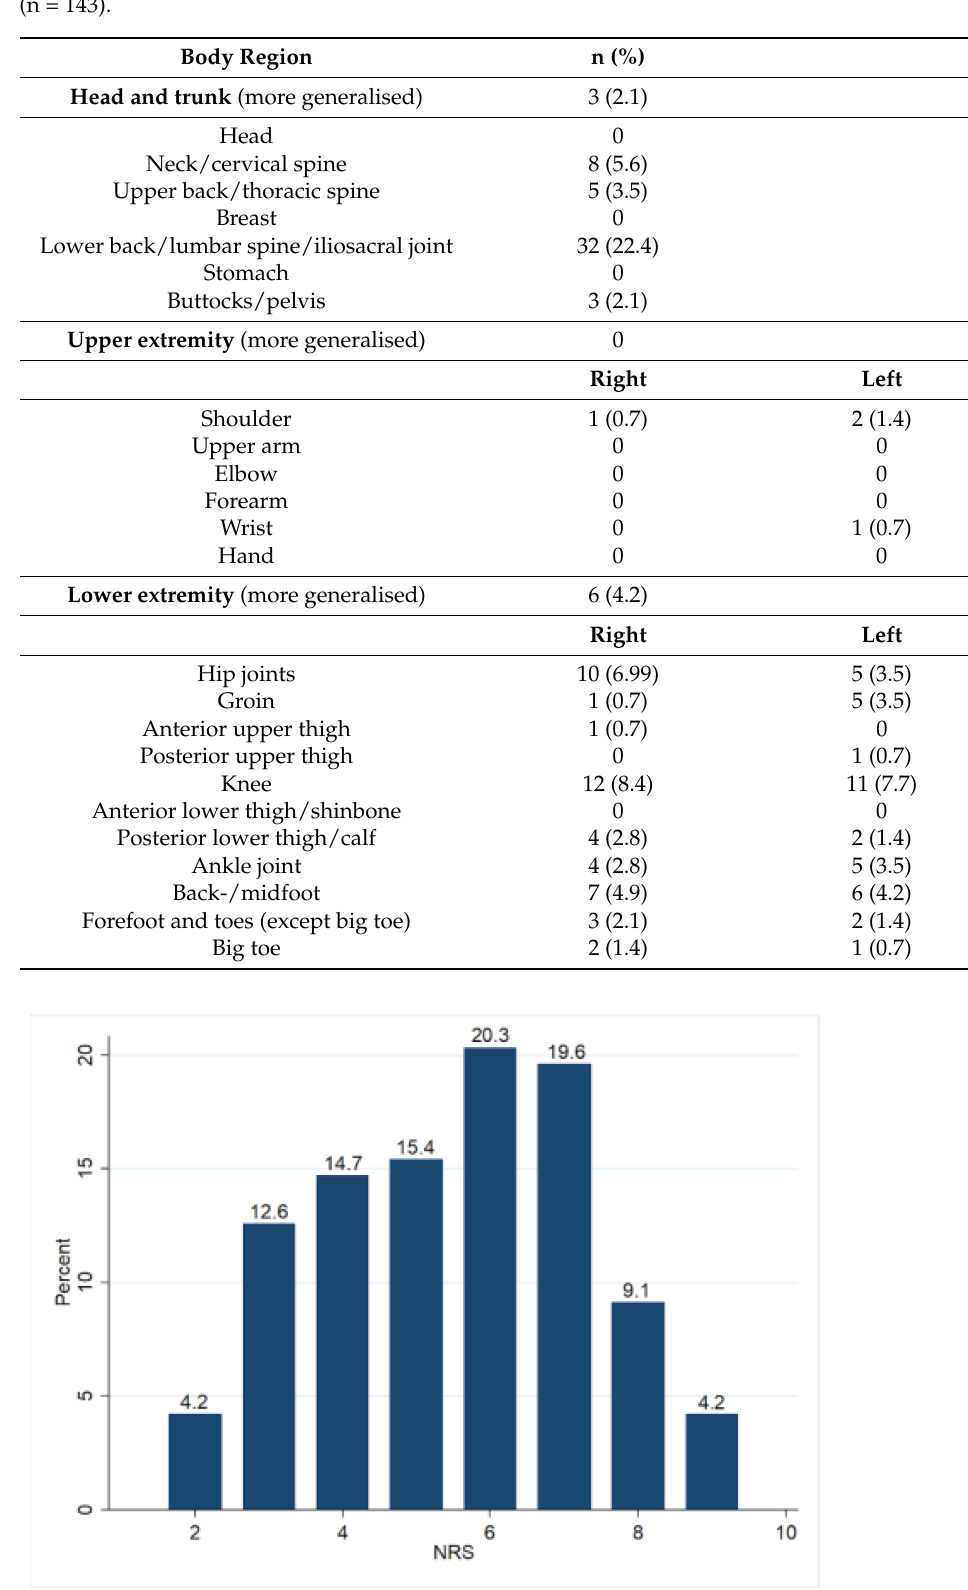
Table 1. Most severely affected pain regions of dance teachers in pain during the three month period (n = 143).